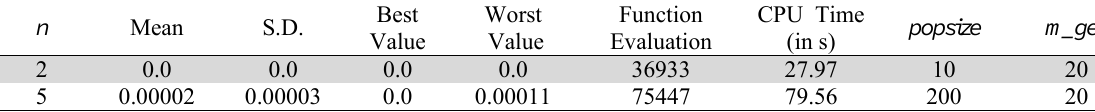
Computational Results of Problem -4